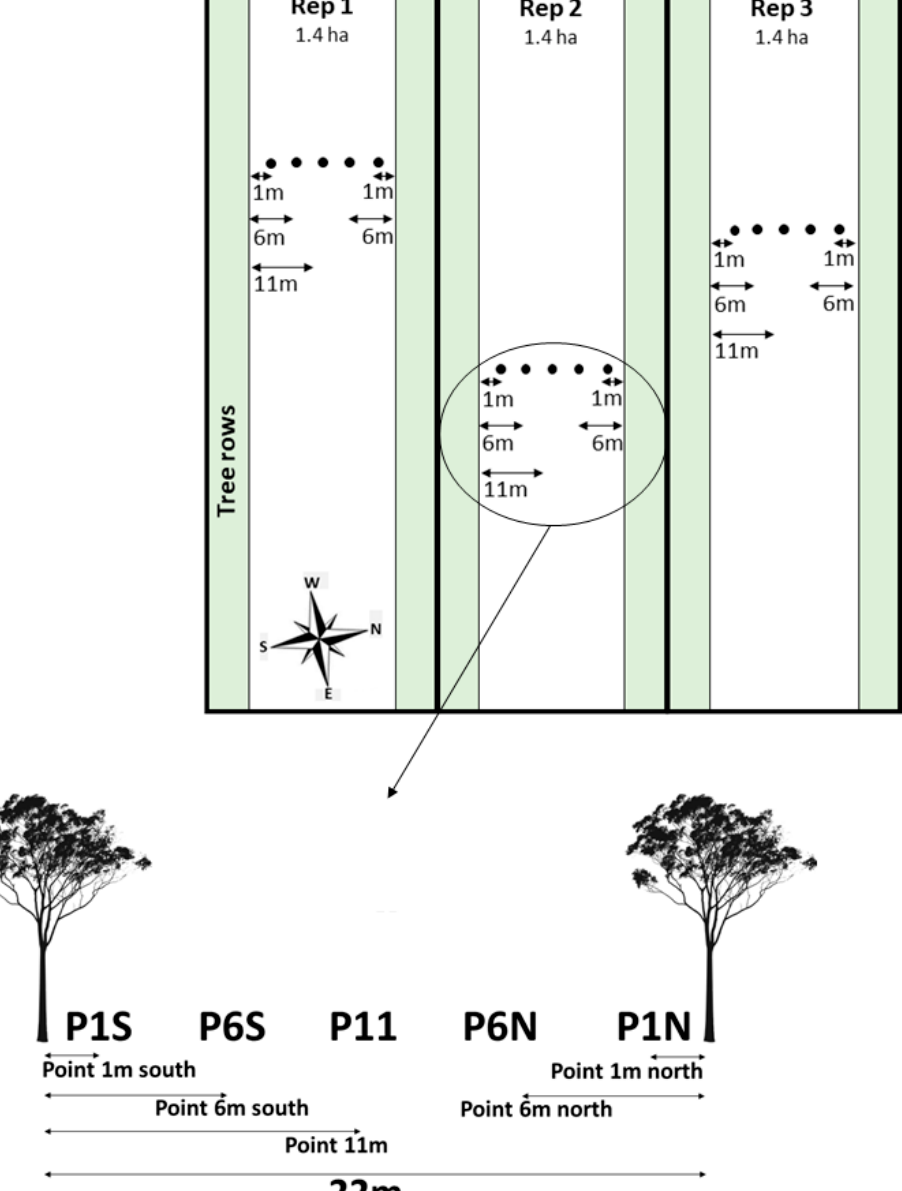
Figure 2. Schematic representation of the experimental plots indicating sampling and measurement points in each replicate. Green stripes represent the tree rows. Each replicate had two tree rows. Within the tree rows all data were sampled according to the distance to the trees. P1S: 1 m and P6S: 6 m from southern row. P1N: 1 m and P6N: 6 m from northern row. P11: 11 m from southern and northern row respectively.